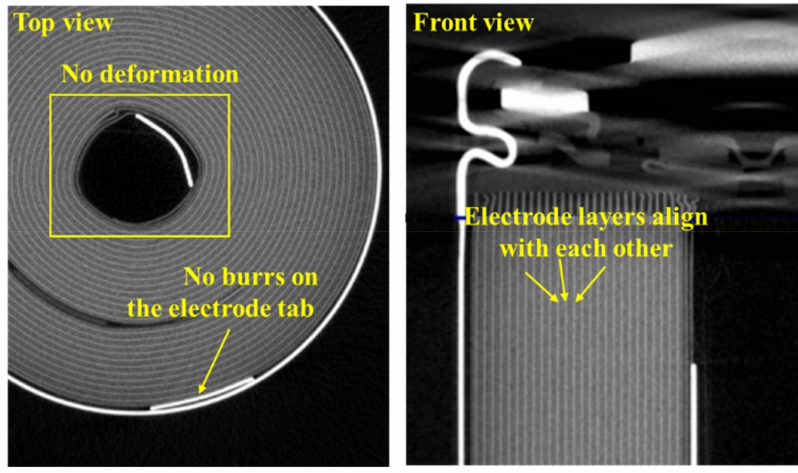
Figure 8. Magnified CT scan images of a cylindrical lithium-ion